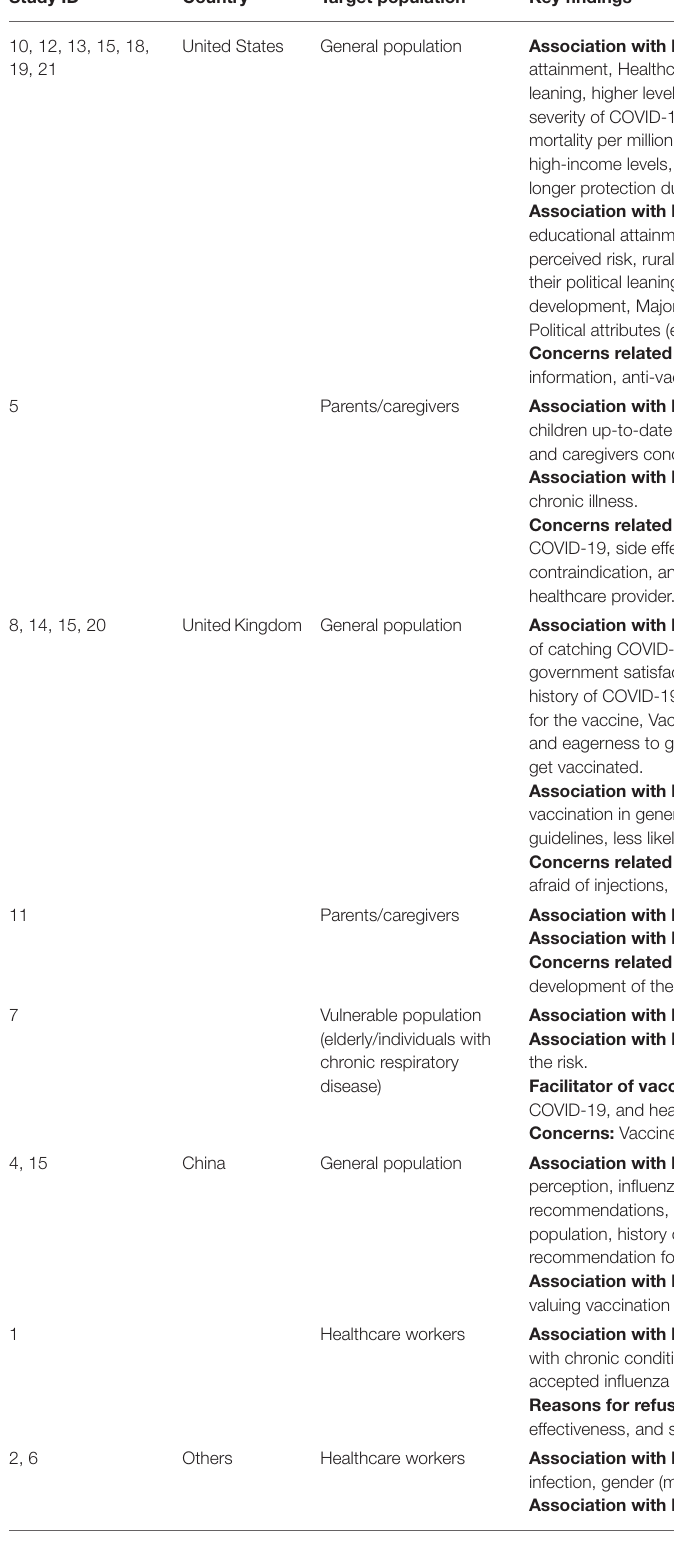
TABLE 6 | The detailed key finding of included studies: country-wise. Study